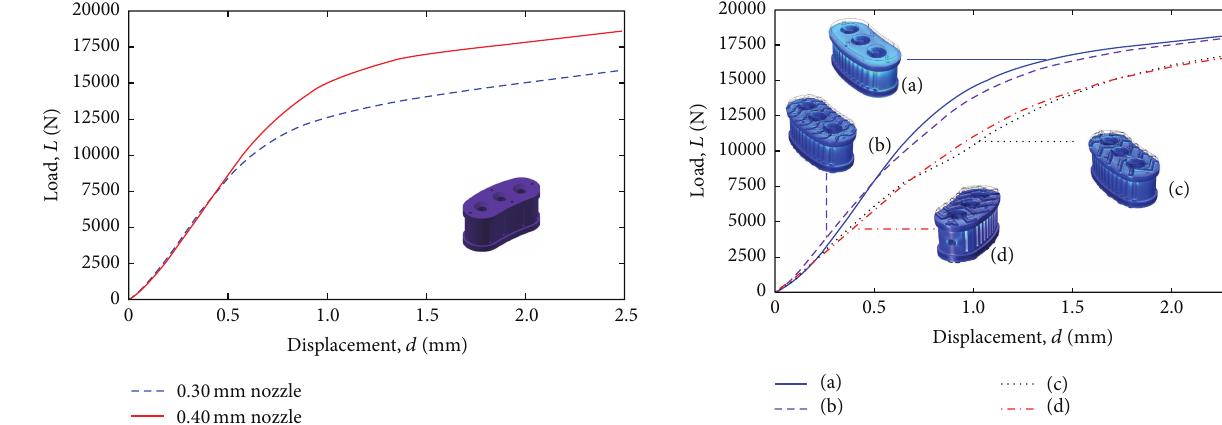
10,000 N. A load of approximately 7,500 N is supported by design concepts (c) and (d) before yielding is observed.